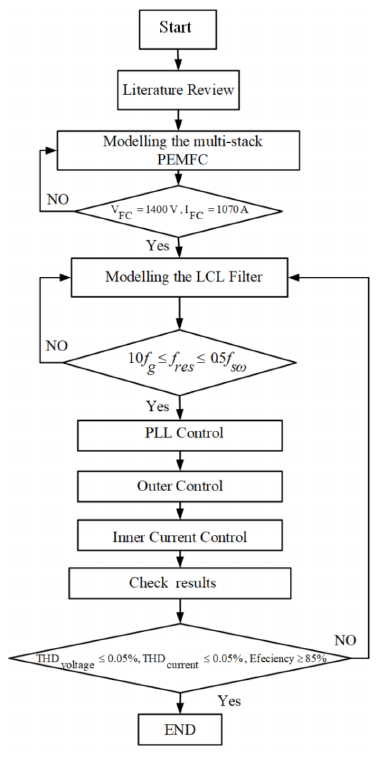
Figure 2. Research design